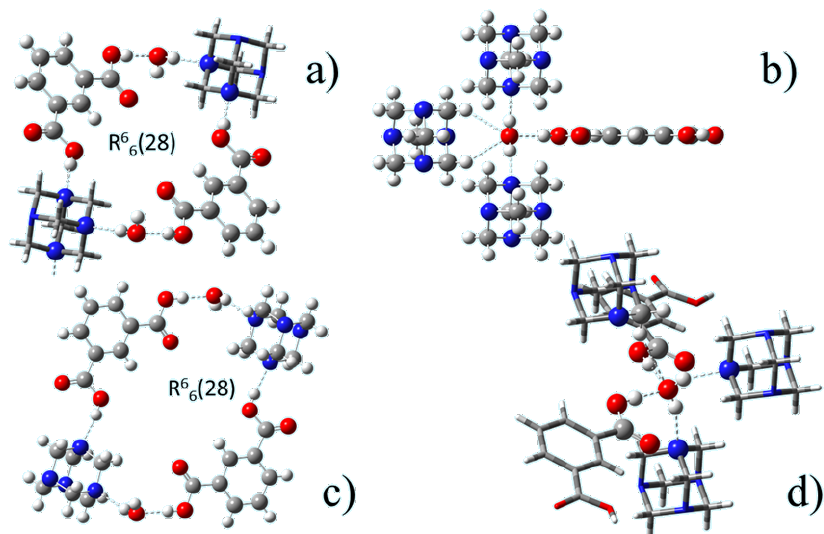
Figure 3. Hydrogen bond motif in compound 1 ( a,b ) and in compound 2 ( c,d ).